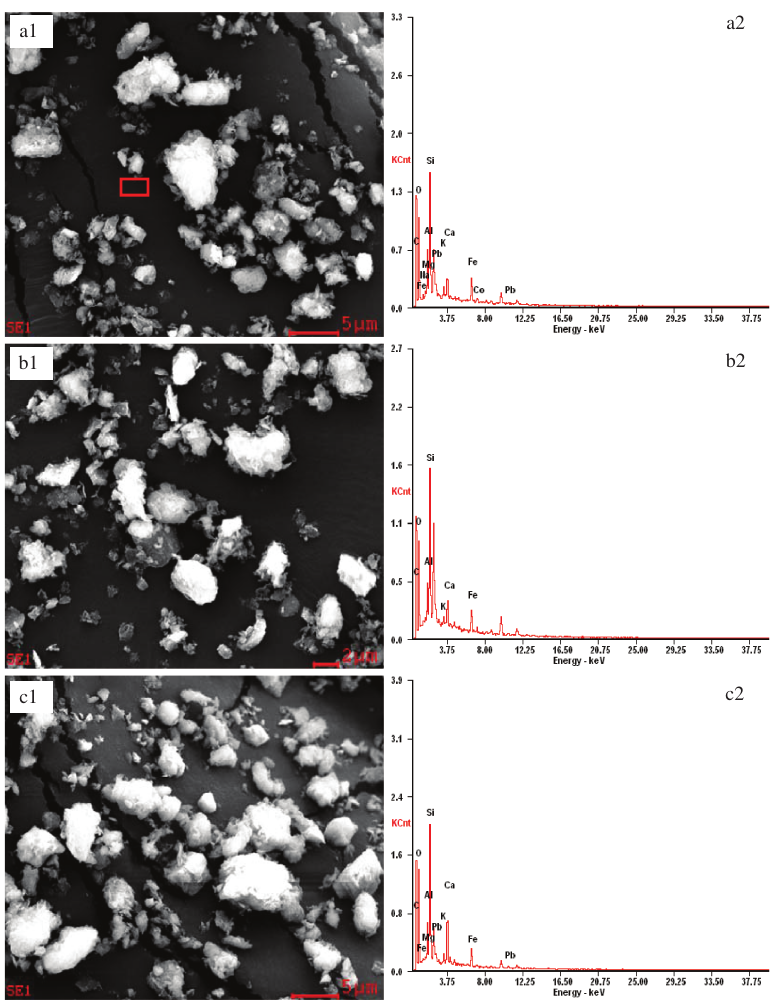
Figure 6: SEM images and EDS patterns of leaching slags under different sodium citrate contents (a1) and (a2): [Na 3 C 6 H 5 O 7 ] 0 mol/L; (b1) and (b2): [Na 3 C 6 H 5 O 7 ] 0.2 mol/L; (c1) and (c2): [Na 3 C 6 H 5 O 7 ] 0.35 mol/L.